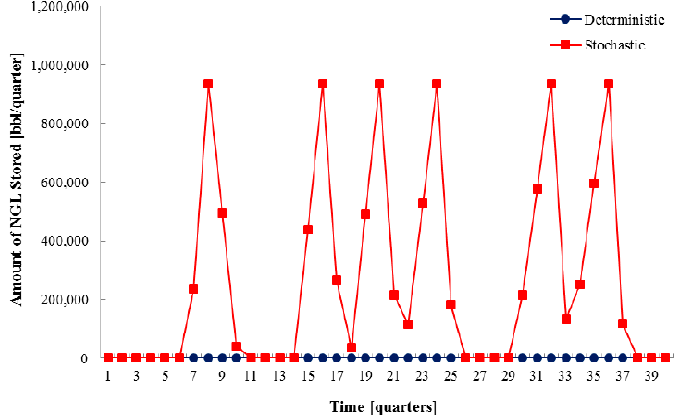
Figure 11. Variation of NGL stored for deterministic and stochastic cases.